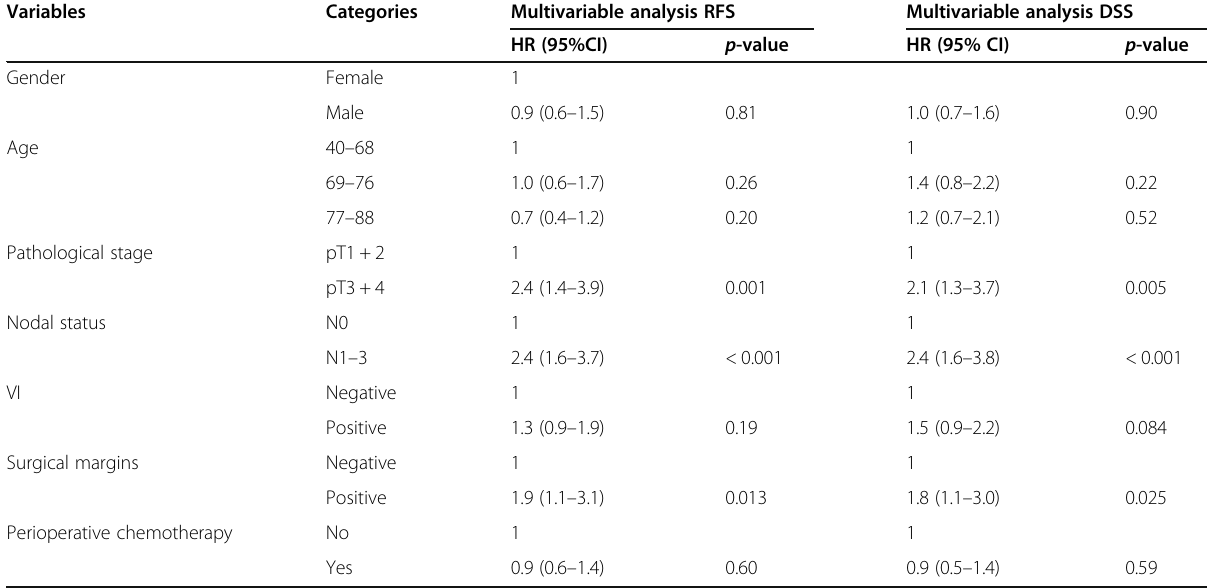
Table 4 Multivariable analyses of RFS and DSS (Cox proportional hazard method) of pathological variables and vascular invasion assessed without immunohistochemistry ( n = 256*)